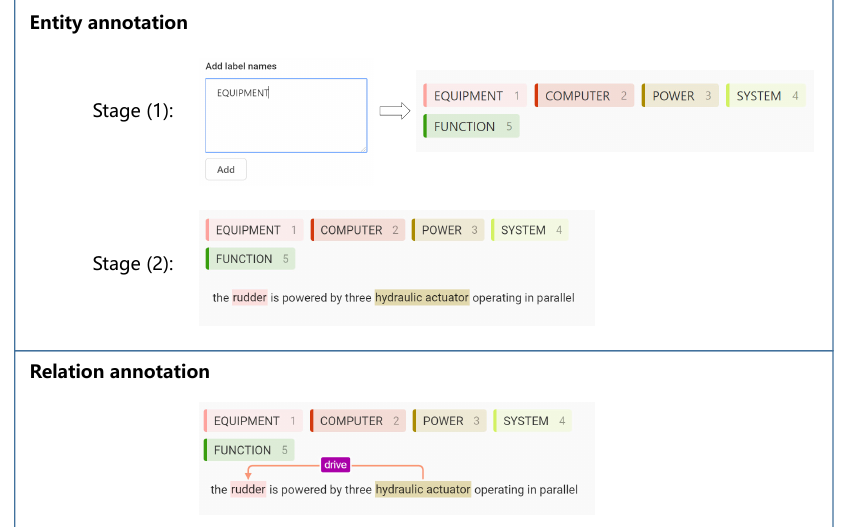
Figure 4. An example of entity and relation annotation.